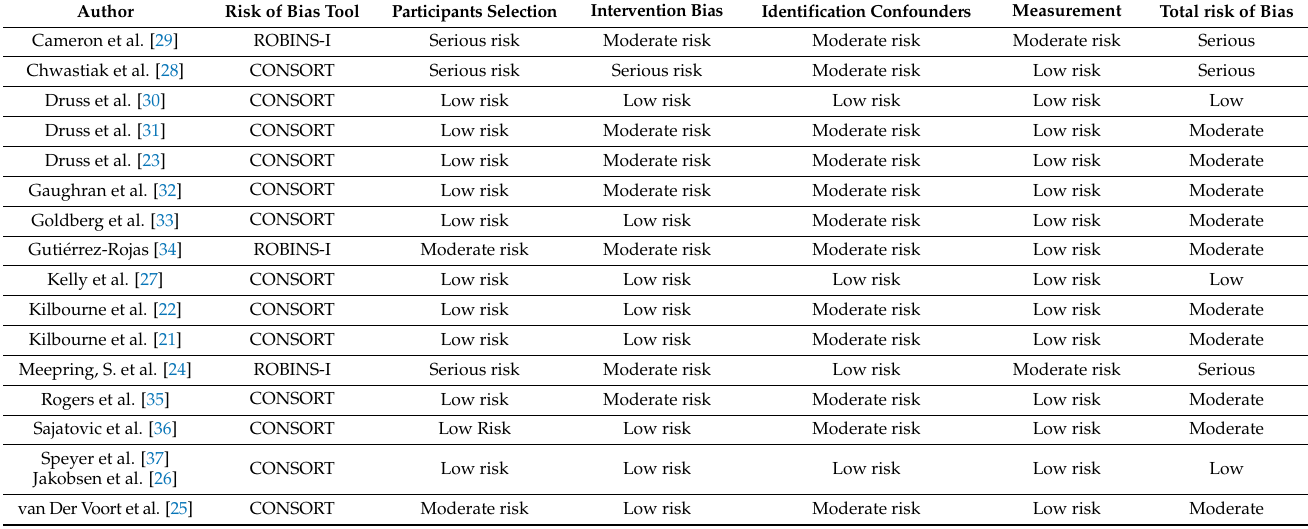
Table 1. Risk of Bias Assessment of the included